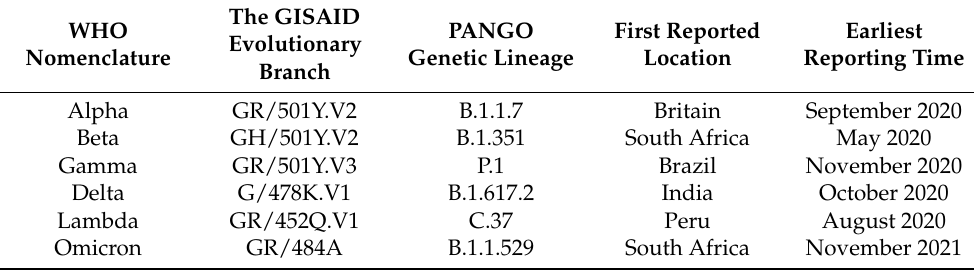
Table 2. Representative variants of SARS-CoV-2.